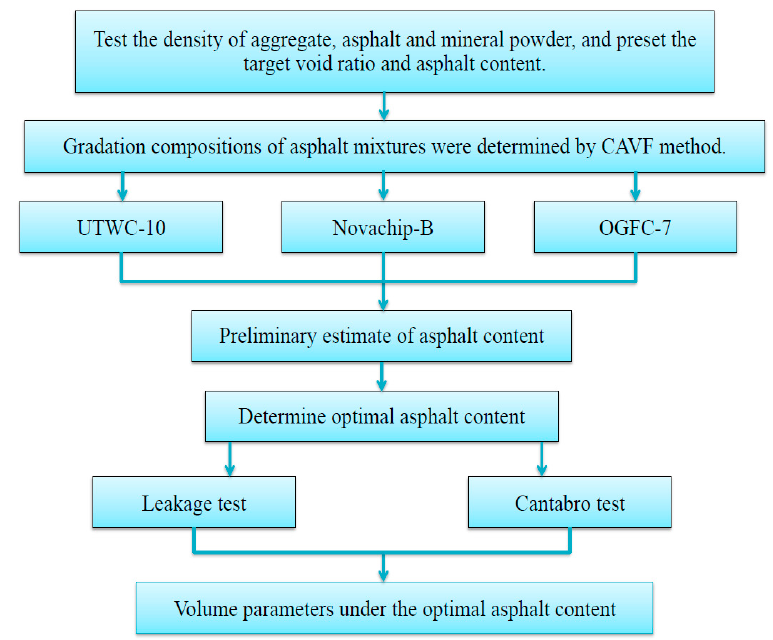
Figure 1. Design process of three asphalt mixtures.